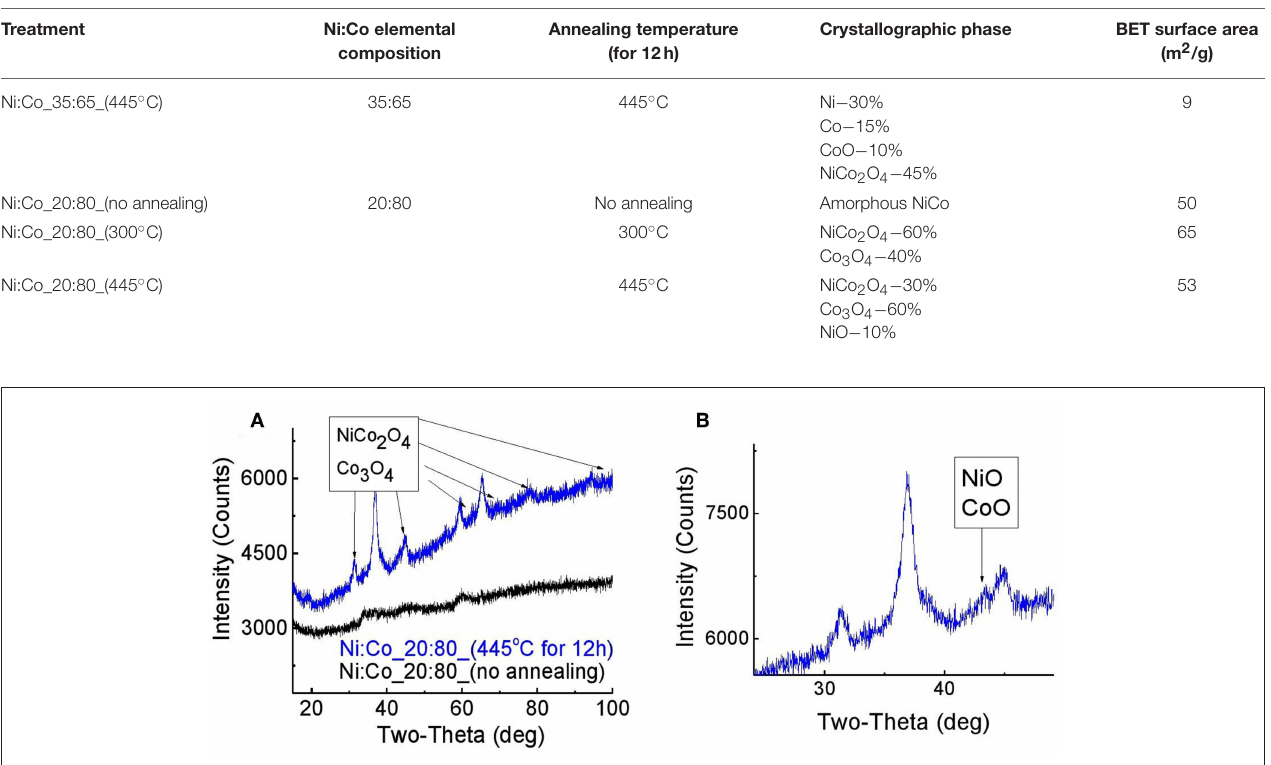
FIGURE 3 | XRD pattern of Ni:Co_20:80 powder before and after annealing at 445 ◦ C for 12h (A) full spectra (B) magnification of NiO/CoO peak.